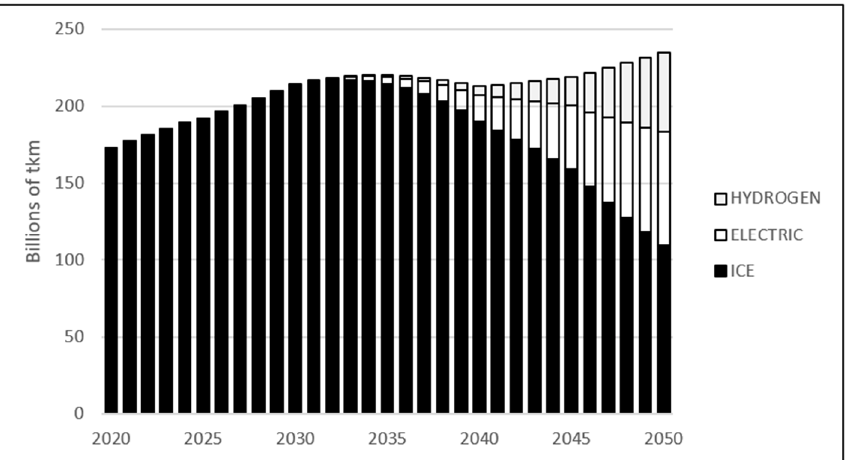
Figure 6. Freight road transport activity in Poland in the years 2020–2050 [in tkm]. Source: own calculations based on TR 3 E model results.